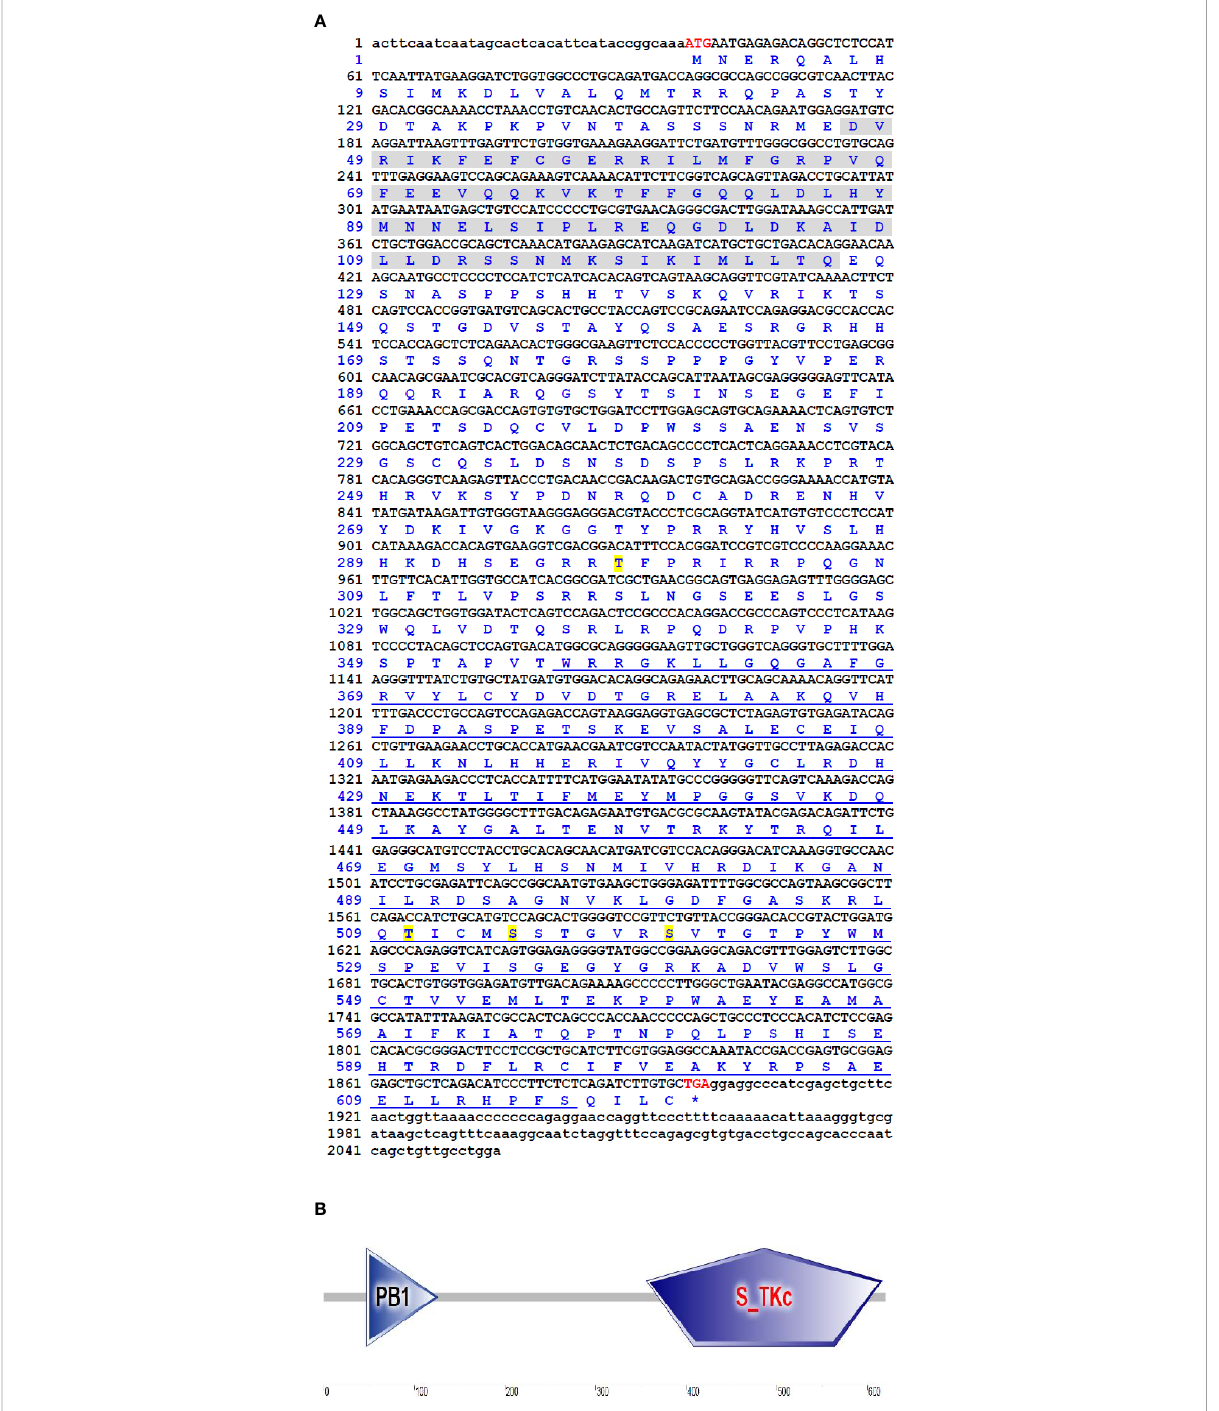
FIGURE 1 The cDNA sequence and deduced amino acid sequences of Ci MEKK3. (A) Nucleotides and amino acids are numbered on the left of the sequences. The start codon (ATG) and stop codon (TGA) are shown in red font. The ORF sequence of Ci MEKK3 is indicated in uppercase letters, while the 5 ′ - and 3 ′ -UTR sequences are shown in lowercase. The PB1 domain and S_TKc domain are marked by gray shading and blue underline, respectively. The predicted phosphorylation sites are shown by yellow shading. (B) Functional domains of Ci MEKK3 were predicted using the SMART